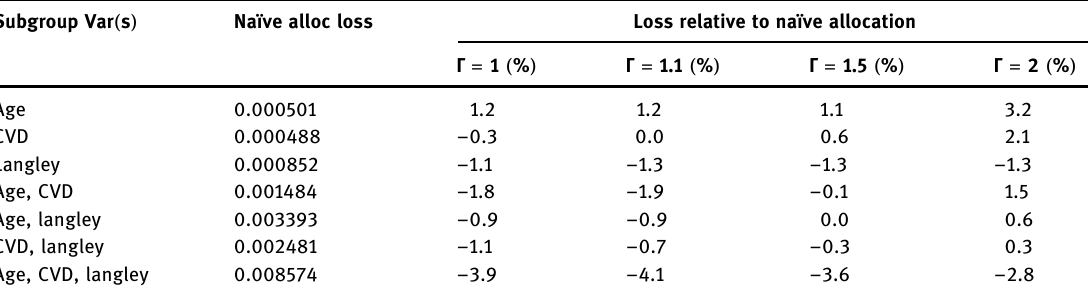
Table 2: L 2 loss comparisons for regret - minimizing allocations relative to naïve allocation Subgroup Var ( s